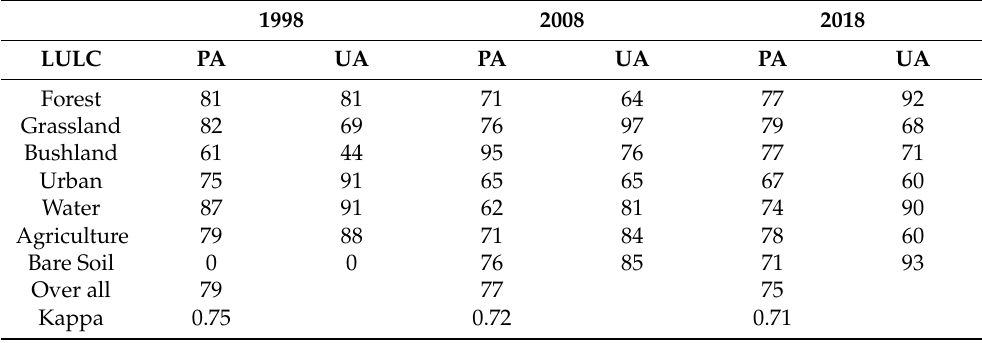
Table 5. Accuracy assessment of LULC classification for WMS corridor, Tanzania, for 1998, 2008, and 2018. LULC = land-use/land-cover change, PA = producer’s accuracy, UA = user’s accuracy.